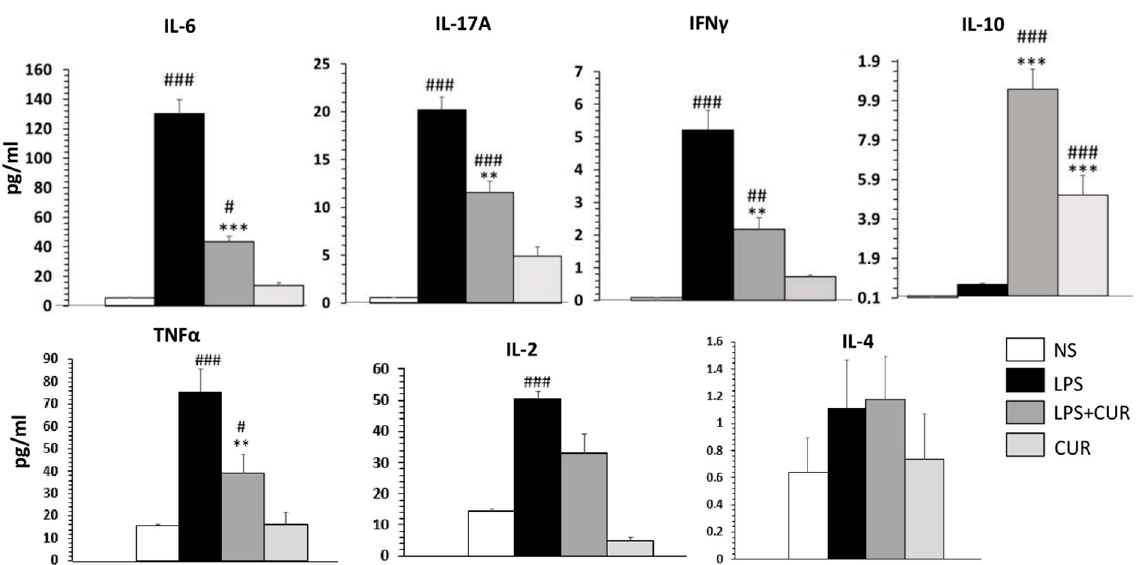
Figure 2. Effect of curcumin on the Th1/Th2/Th17 cytokines release by LPS-stimulated C8-D1A cells. Data are shown as mean ± SEM of three independent experiments in a triplicate assay. # p < 0.05, **/ ## p < 0.01 and ***/ ### p < 0.001.